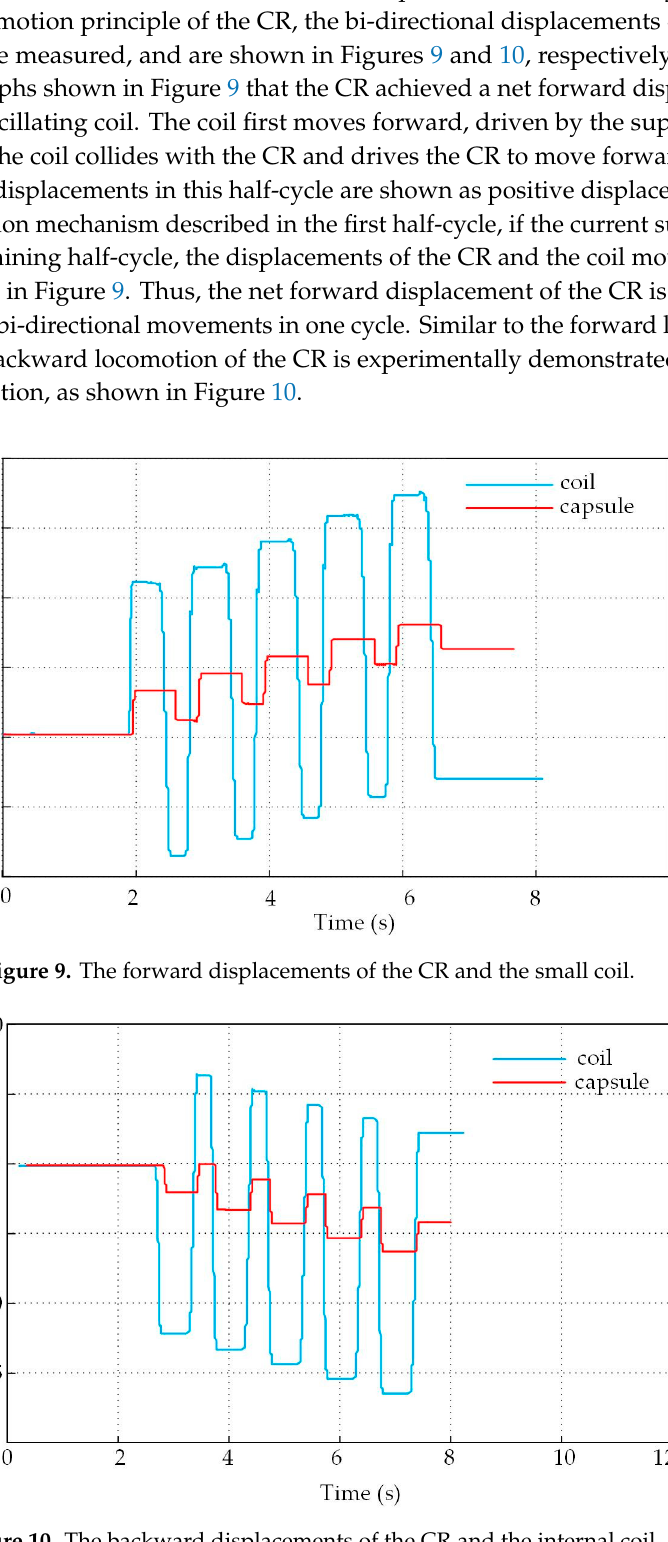
Figure 10. The backward displacements of the CR and the internal coil.